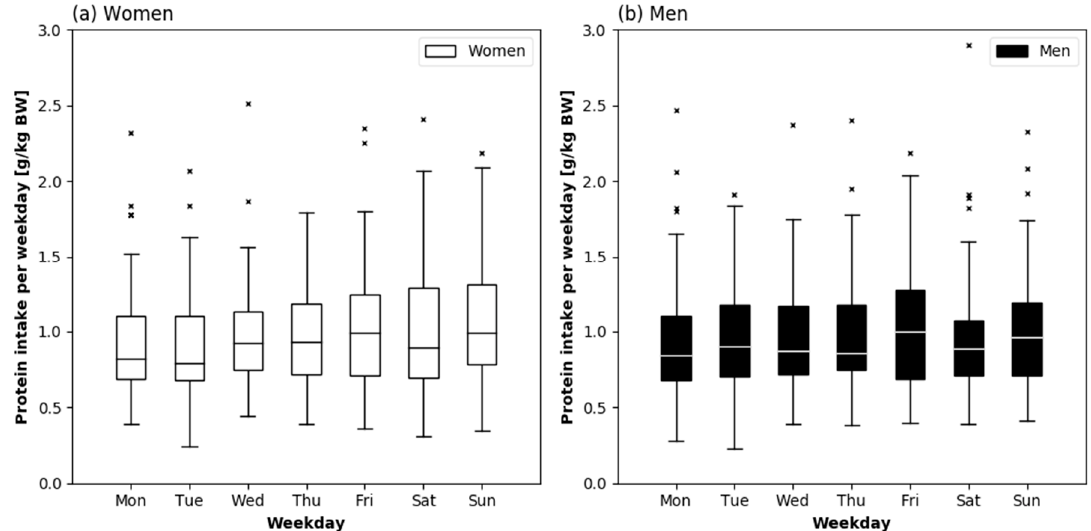
Figure 1. Daily protein intake relative to body weight (BW) by weekday in healthy community-dwelling older women ( n = 72) ( a ) and men ( n = 68) ( b ). Friedman’s test: p = 0.013 in women, p = 0.198 in men. The boxes represent interquartile ranges with the horizontal lines denoting the median. The whiskers show the highest and lowest values within the 1.5-fold interquartile range. The × represent outliers.